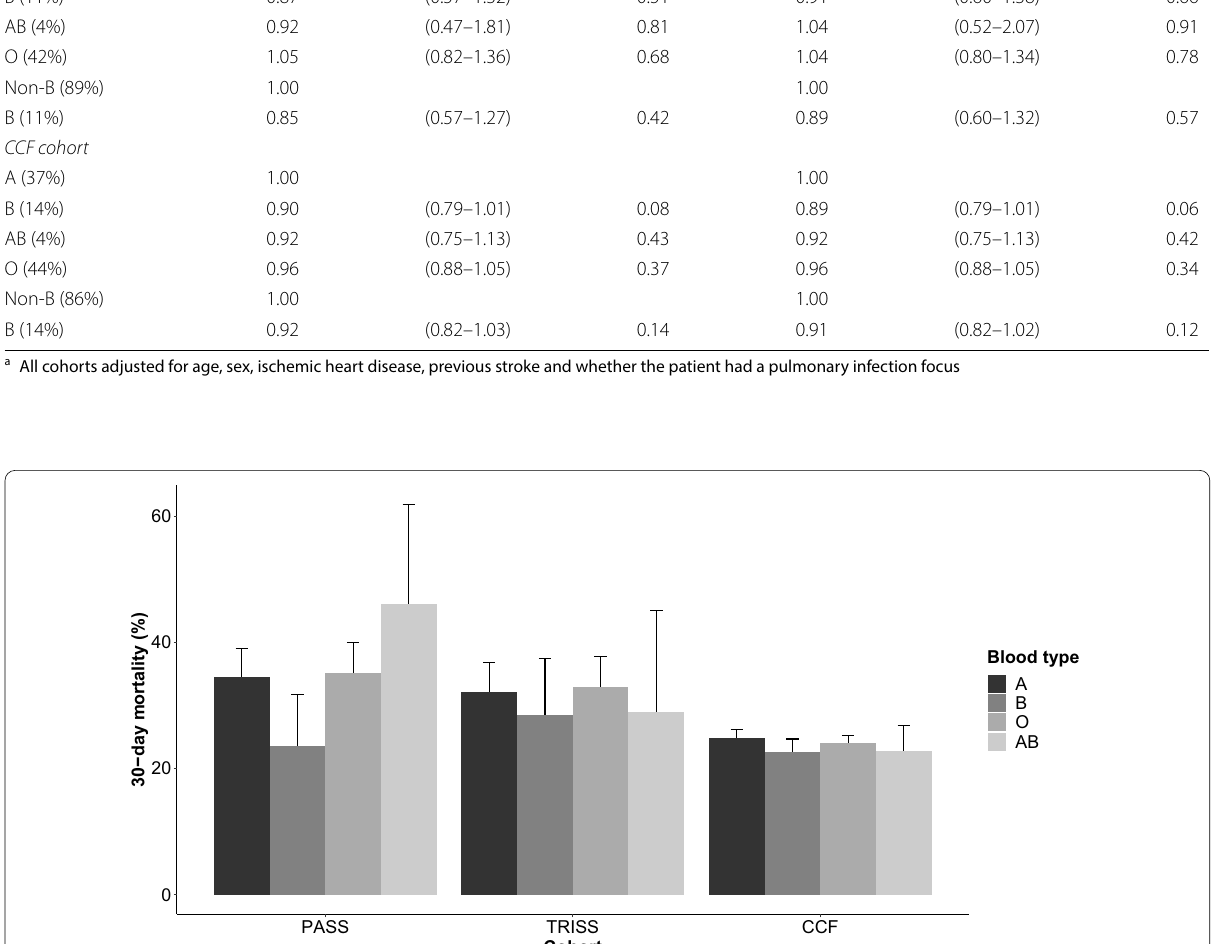
Fig. 2 Crude 30‑day mortality in three independent ICU cohorts